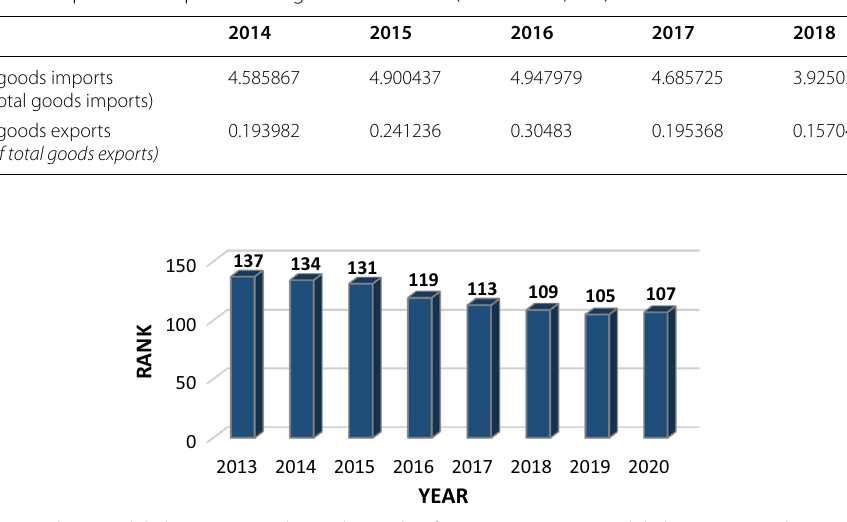
Fig. 1 Pakistan’s Global Innovation Index Ranking in last few years (Dutta, 2015, Global Innovation